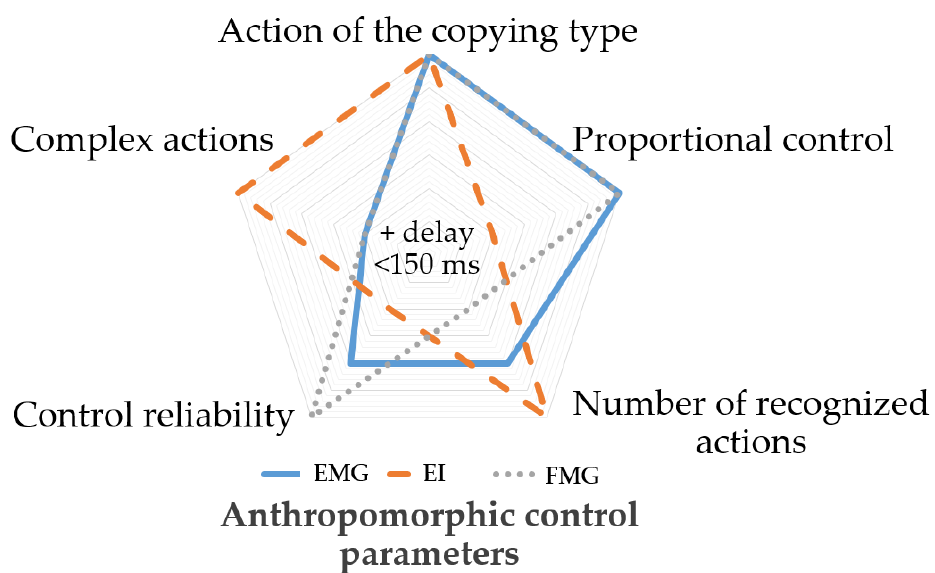
Figure 1. Anthropomorphic control parameters for EI, EMG, and FMG.